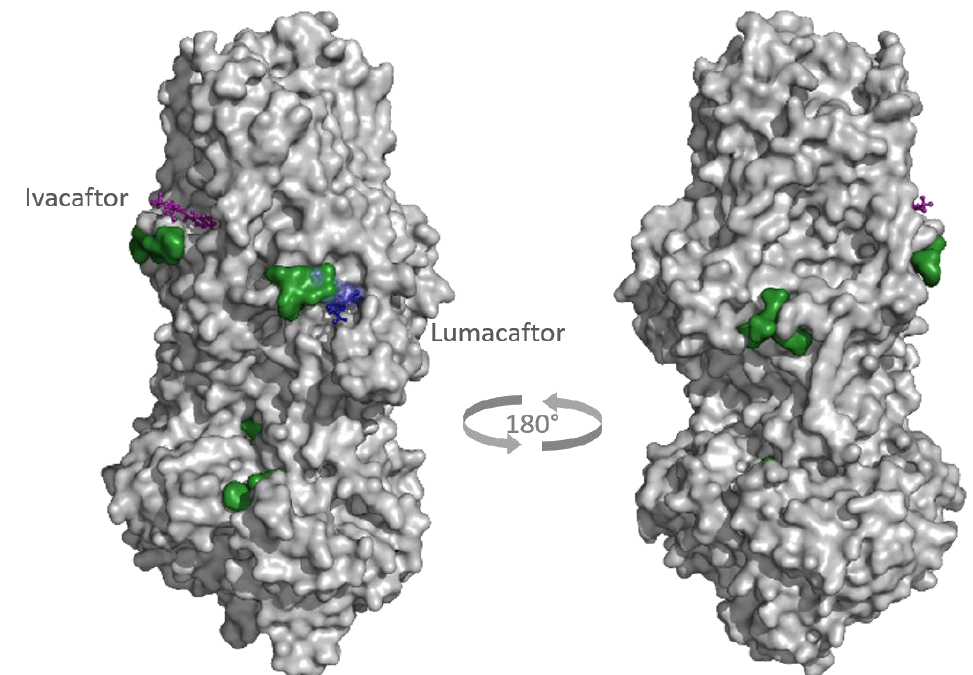
Figure 10. Most predicted binding sites in CFTR by target-based approach (PDB 7SVD and 6O2P). Coloured in green are the potential binding sites. The positions of Lumacaftor (blue) and Ivacaftor (purple) were shown experimentally by Fiedorczuk and Chen, 2022 [63]. Shown in light blue is the binding site of Lumacaftor predicted by blind docking in the target-based approach, which is in agreement with the experimentally predicted binding site.